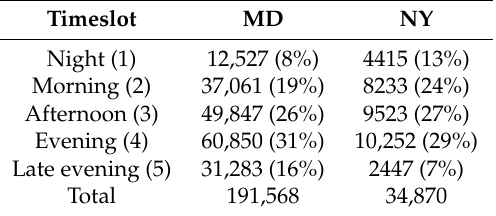
Table 5. Distribution of documents per time slot. Number in brackets are the percentage with respect to the